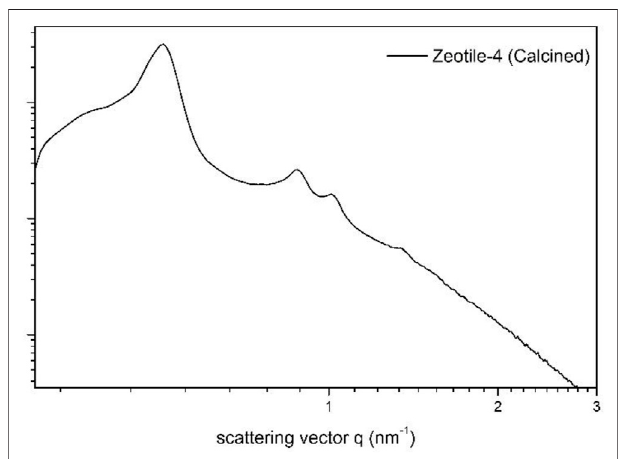
FIGURE 5 | Small-angle x-ray scattering pattern of calcined zeotile-4 (reproduced from Pulinthanathu Sree et al., 2012 with permission from the American Chemical Society).